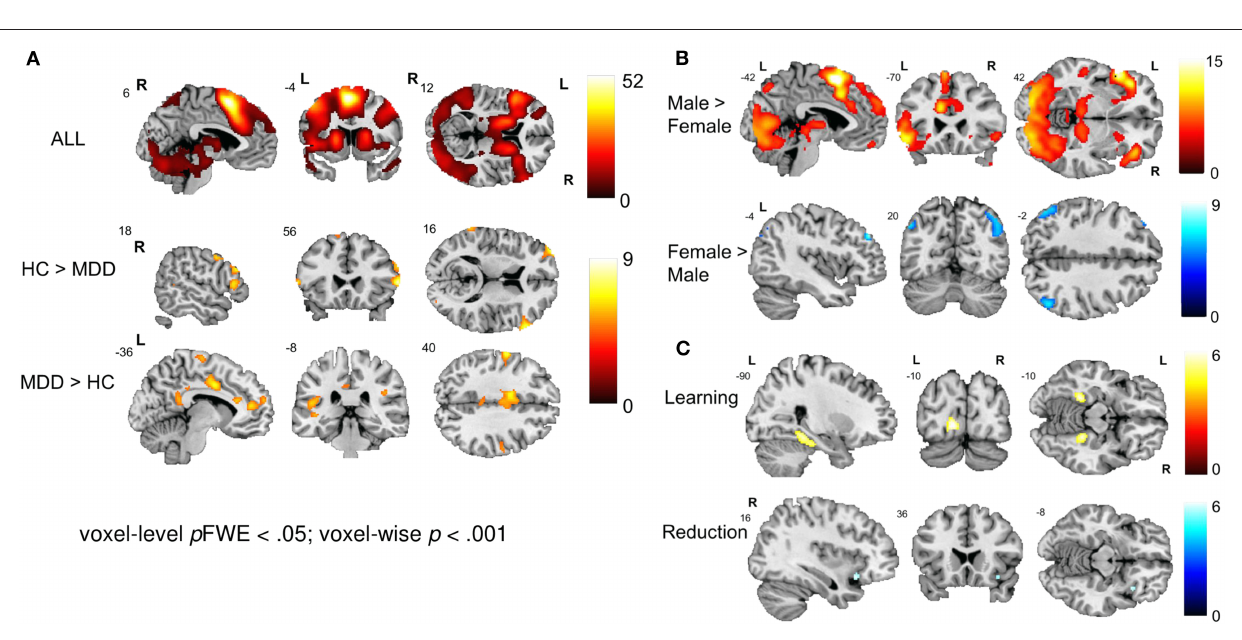
an increase in bilateral fusiform gyrus and occipital lobe as well as a decrease of activation in the right insula ( Figure 3C ; Table 3